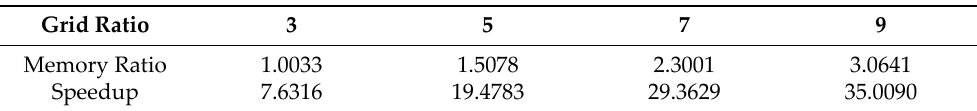
Table 1. Memory ratio and speedup in conventional FDTD (CPU) and subgridding FDTD (CPU‑ GPU) for different grid